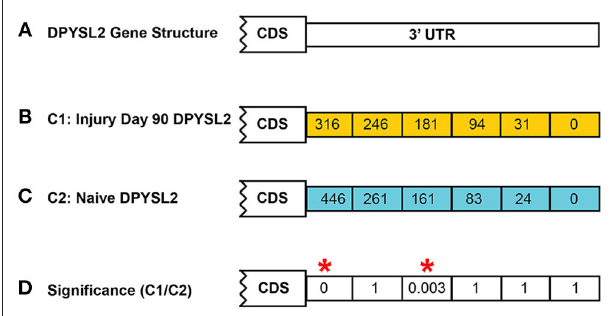
FIGURE 4 | Example of CSI significance calculation. Shown is the calculation of the FDR-corrected significance for dihydropyrimidinase like 2 ( DPYSL2 ) in the rat injury day 90 vs. naïve. A total of six possible CSIs have been identified for DPYSL2 (A) . Normalized CSI counts for the injury and naïve conditions are shown in (B,C) , respectively. FDR-corrected significance values for each CSI are shown in (D) . Statistically significant regions, as determined by Fisher’s exact test, are highlighted by a